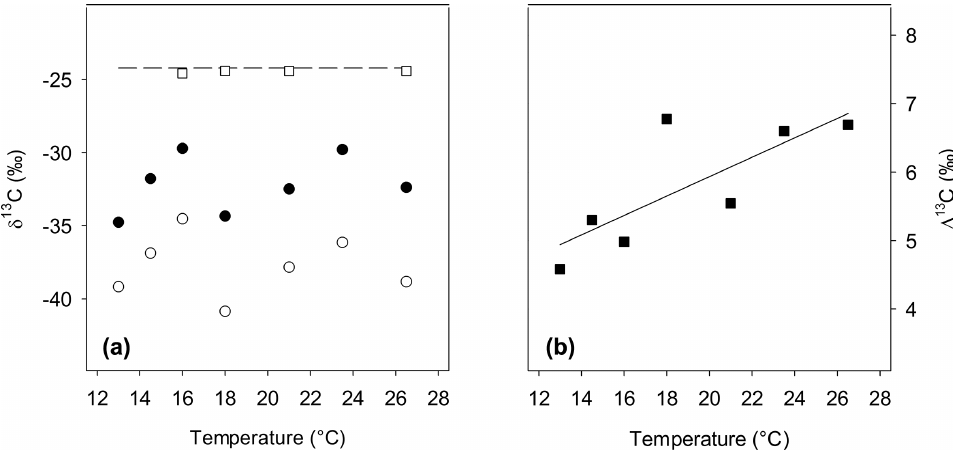
; a ), and C isotope discrimination during respiration ( (cid:49) 13 C;